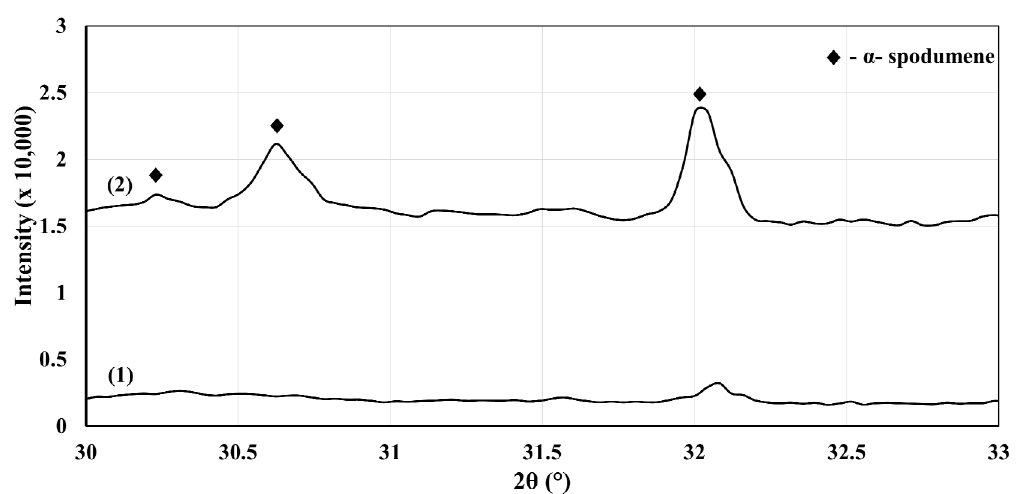
Figure 7. XRD patterns of sample M: (1) initial heat-treated concentrate, (2) aged heat-treated concentrate. Table 5. Rietveld quantifications on XRD patterns of initial and aged heat-treated concentrates. Time Sample